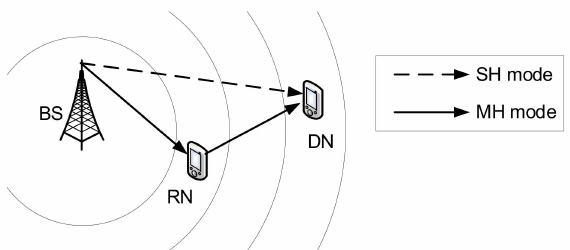
Figure 1. Single Hop (SH) and Multi-Hop (MH) modes in a 2-hop Multi-hop Cellular Network (MCN)